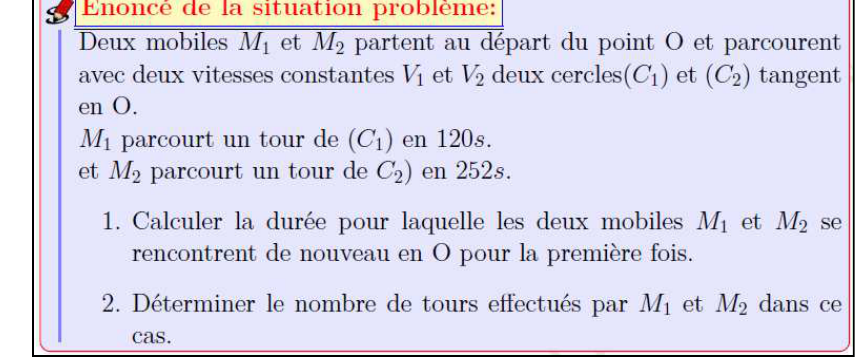
Fig. 6. Simulation du problème d’optimisation avec un logiciel de géométrie dynamique (GeoGebra).